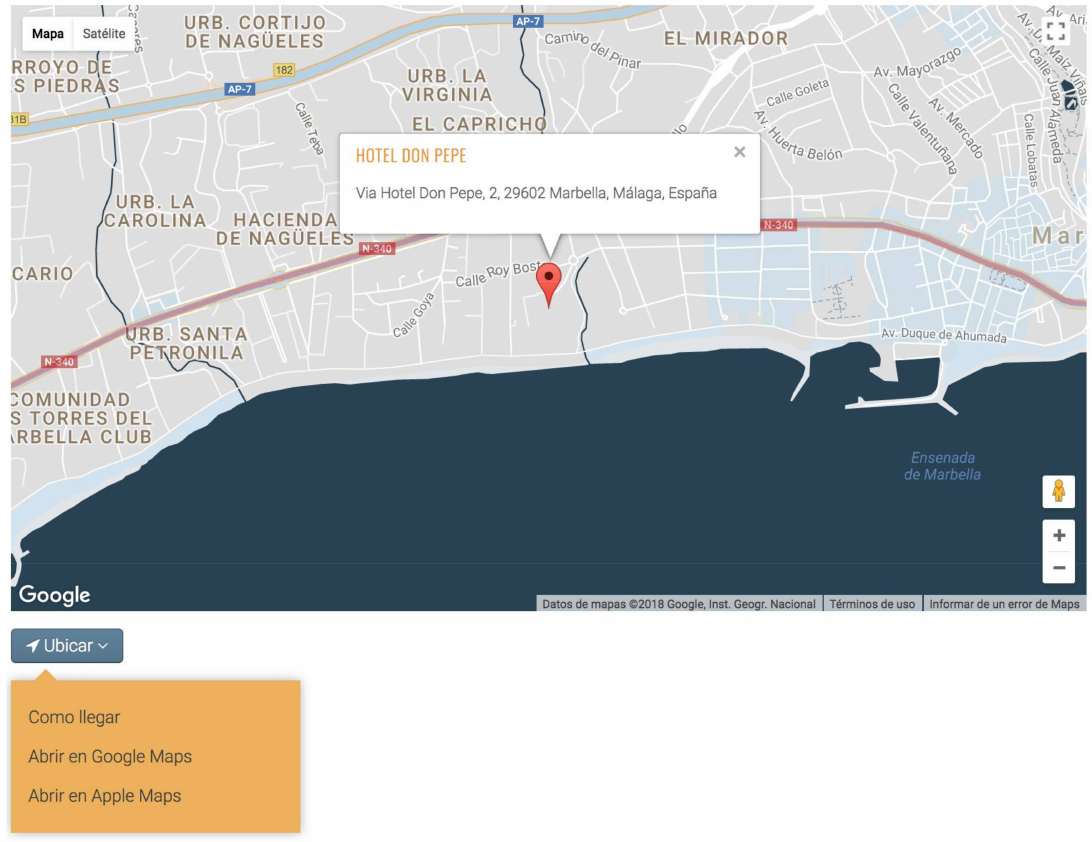
Figure 12. Locating an item on a custom Google Map. Locating “Hotel Don Pepe” on the front end (https://n-340.org/patrimonio/items-patrimoniales/malaga/marbella/hotel-don-pepe/). Screenshot by the N-340 research team, January